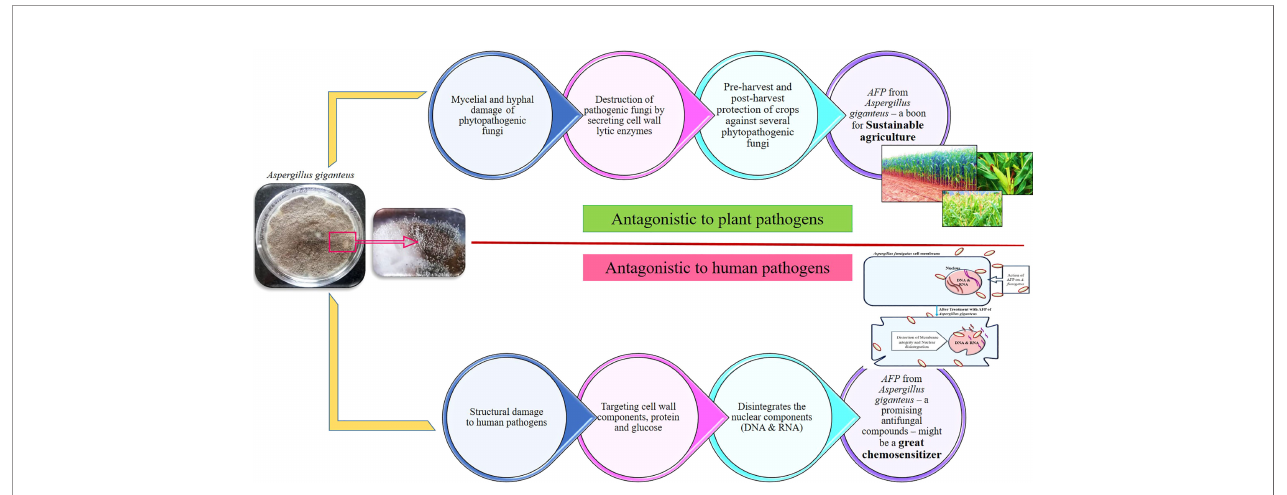
FIGURE 4 | Antagonistic mechanism of AFP from Aspergillus giganteus on plant and human fungal pathogens. As a biocontrol agent, it selectively inhibits and kills the growth of plant fungal pathogens by secreting speci fi c cell-wall degrading enzymes namely, amylase, protease, b -1,3 glucanase, chitinase, and cellulase. As antifungal compounds in clinical area, it could possibly perturb the membrane of human fungal pathogens by interfering with the cell wall components and nuclear components. AFP from Aspergillus giganteus might be a promising biocontrol agent for sustainable agriculture and optimistic novel compounds for the treatment of systemic fungal infections. In addition to their remarkable values, it could be a potent chemosensitizer to sensitize the plant and human fungal pathogens to commercial fungicides and antimycotic